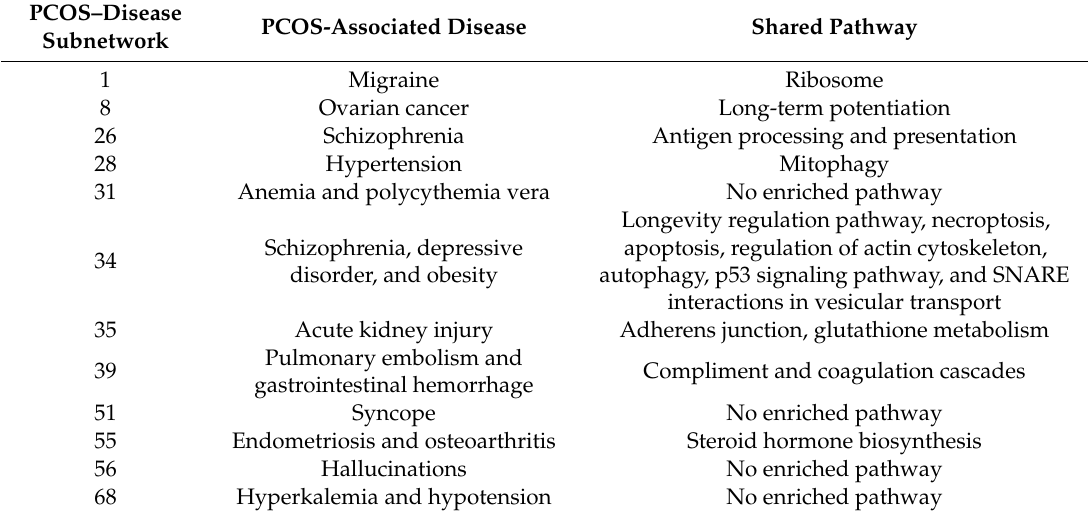
Figure 6. PCOS–disease subnetwork 28. Shared proteins and shared pathway (mitophagy) between PCOS and hypertension were identified from this subnetwork. Different coloring of nodes and lines represents PCOS-related proteins (red), shared proteins (orange), PCOS–disease interactions (blue), and protein–pathway interactions (green). Circle nodes refer to PCOS-related proteins, triangle node refers to disease, and square node refers to pathway. Table 2. Shared PCOS–disease pathways. These pathways were shared between PCOS and respective diseases identified from pathway enrichment analysis.